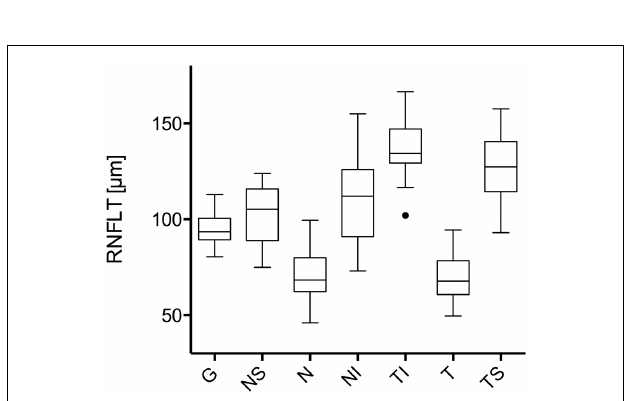
FIGURE 2 | Comparison of the retinal nerve fiber layer thickness in different peripapillary sectors: the different sectors are labeled as follows: global (G), nasal superior (NS), nasal (N), nasal inferior (NI), temporal inferior (TI), temporal (T), and temporal superior (TS) . Data is presented as aTukey box-and-whiskers plot, with values that are above or below the whiskers drawn as individual dots.